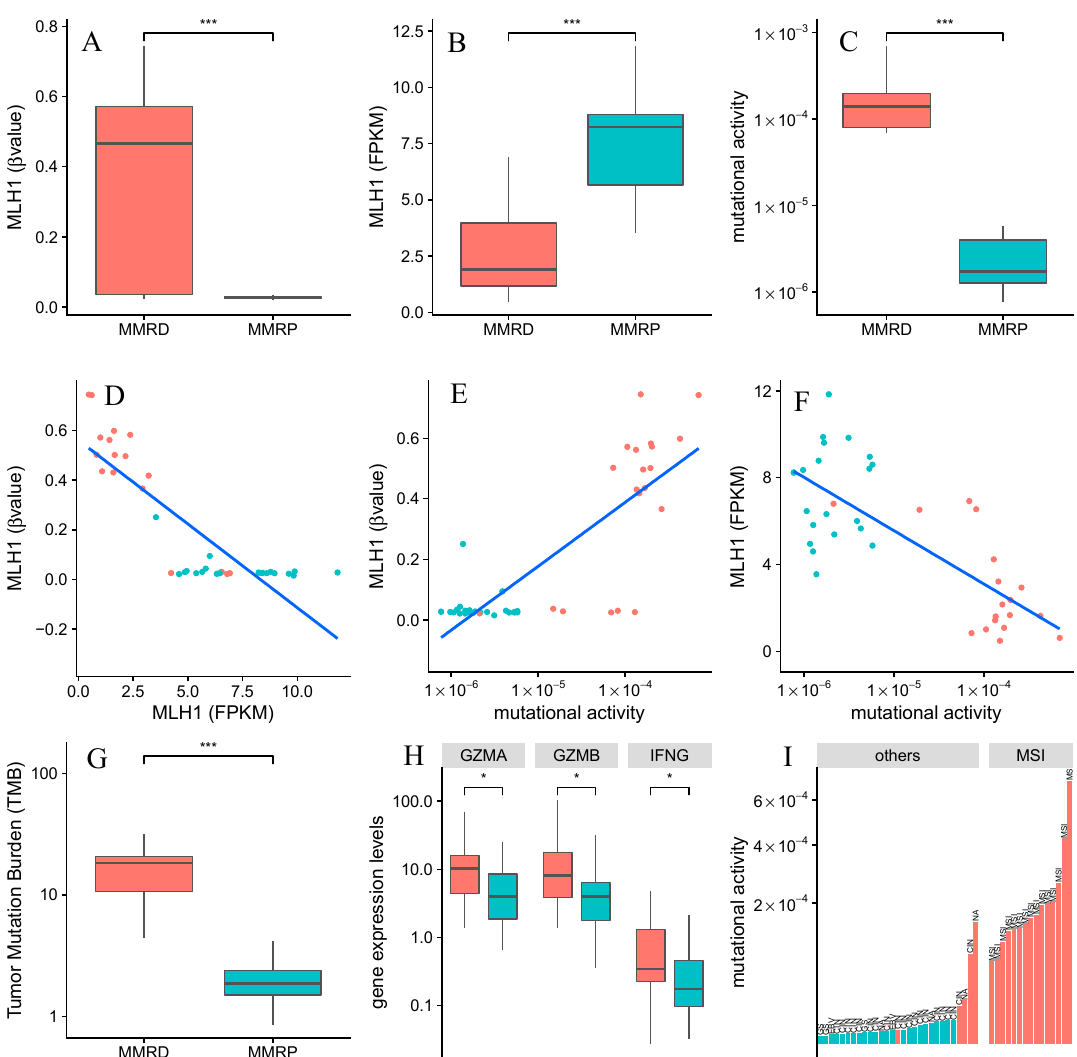
Figure 6. MMR (mismatch repair)-associated molecular drivers. This figure shows the molecular interplay among the MMRD and MMRP predicted groups, which are colored in red and blue, respectively. ( A ) Changes in methylation of MLH1 promoter, ( B ) MLH1 expression levels and ( C ) mutational activity of Signature 20 were detected by comparing MMRD and MMRP groups; Scatterplots showing ( D ) methylation and gene expression levels of MLH1 , ( E ) methylation levels of MLH1 and mutational activity of Signature 20, ( F ) gene expression levels of MLH1 and mutational activity of Signature 20; ( G ) Changes of Tumor Mutation Burden and ( H ) genes related to pro-inflammatory markers across MMRD and MMRP groups. ( I ) Mutational activity of Signature 20 across MSI subtype and others molecular subtypes. Statistical significance was assessed by the two-tailed Wilcoxon Rank Sum and it is indicated by * p < 0.05, *** p < 0.001. The MSI (Microsatellite Instability) and other subtypes (GS: Genomically Stable; EBV: EBV-positive and CIN: Chromosomal INstability) were collected from The Cancer Genome Atlas (TCGA) study.